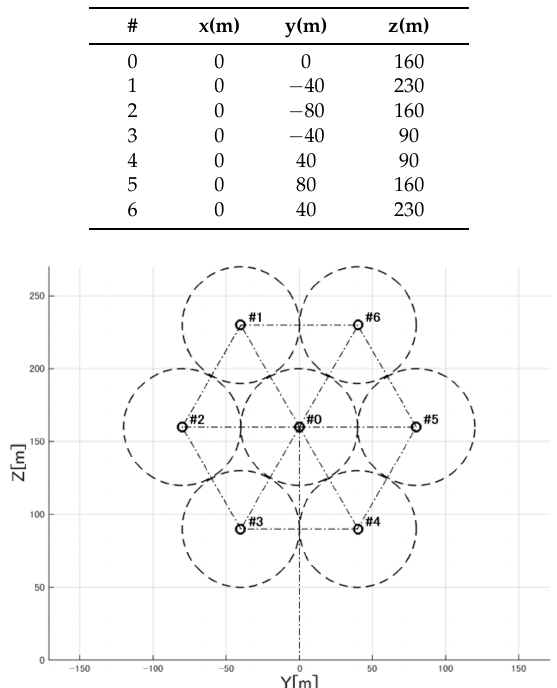
Table 1. Hub centre positions of the 7 × 2 MW MRS.